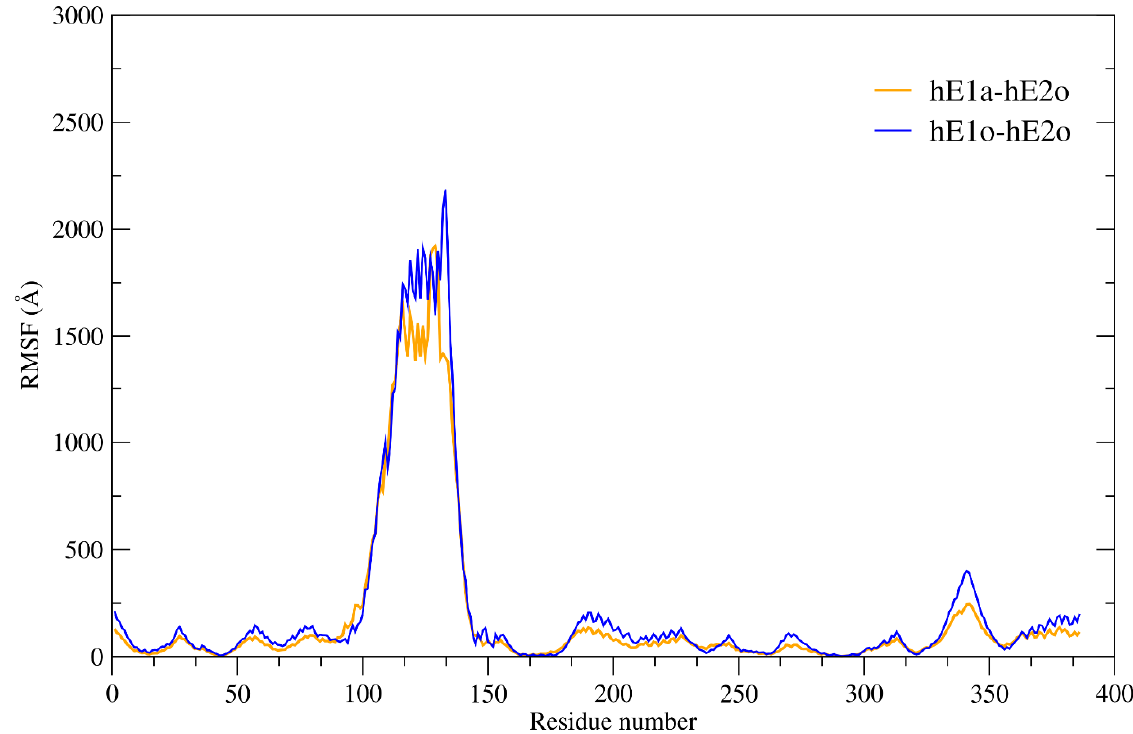
Figure 6. Conformational changes in hE2o on interaction with hE1o ( blue ) or hE1a ( orange ). RMSF is measured in Å.